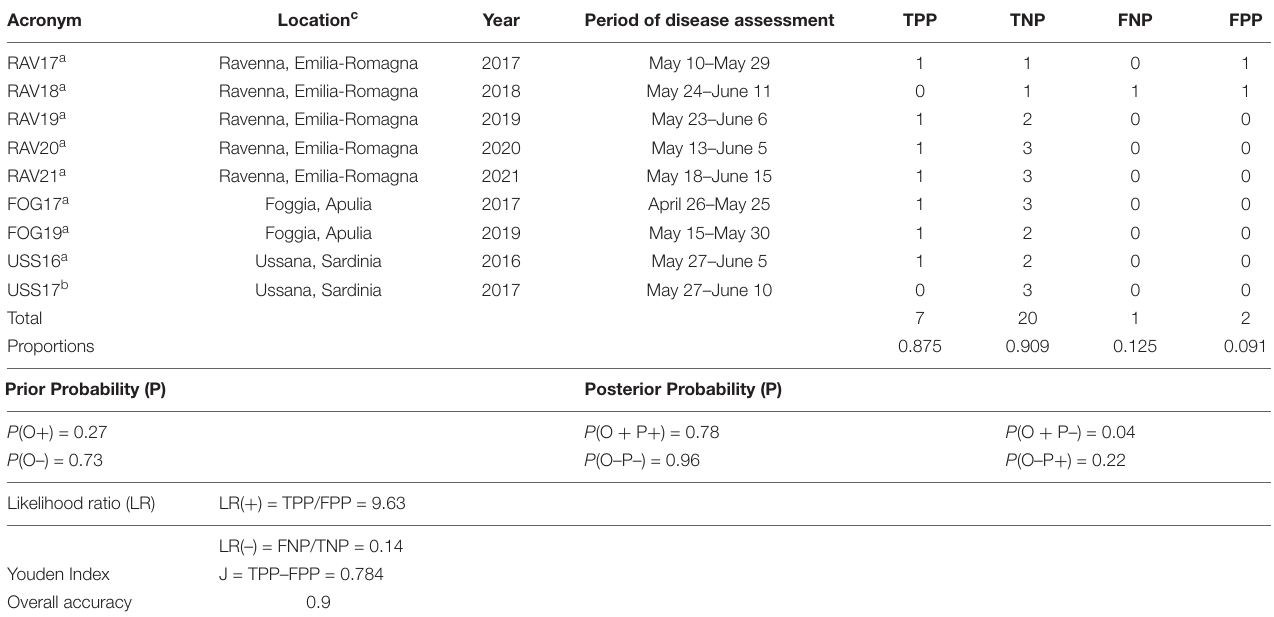
TABLE 2 | Comparison between predicted and observed first seasonal infection in the experimental sites in Italy (acronyms for locations and years), periods of disease assessment, and corresponding properties of the model.